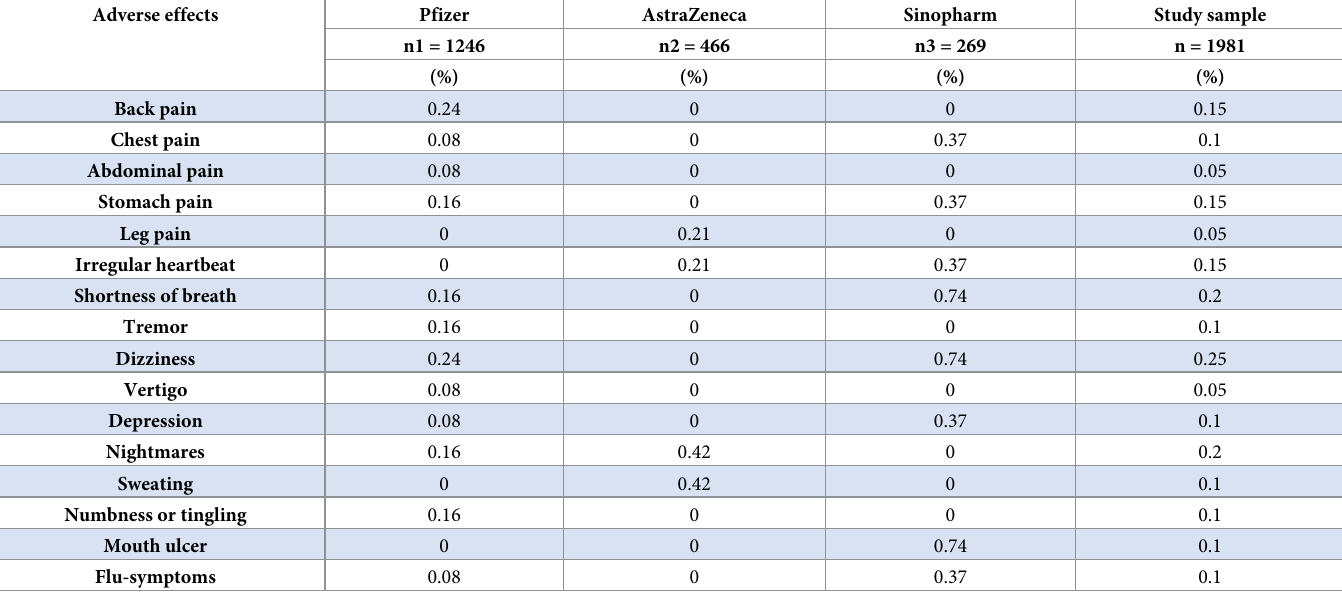
Table 2. Other unlisted adverse effects associated with the first dose of COVID-19 vaccines.